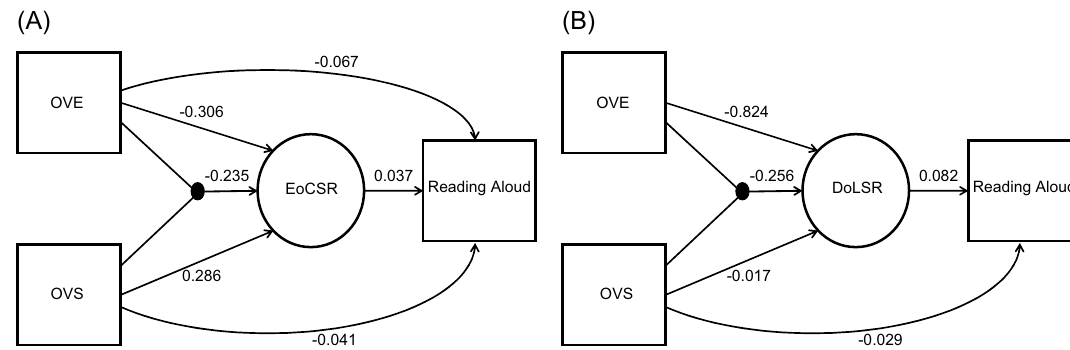
Figure 5. Structural regression analysis of model performance in the reading aloud task with OVE, OVS, and their interaction as measured variables and with ( A ) EoCSR or ( B ) DoLSR as a latent variable. OVE oral vocabulary exposure, OVS oral vocabulary size, EoCSR semantic reliance based on the effect of consistency, DoLSR semantic reliance based on the division of